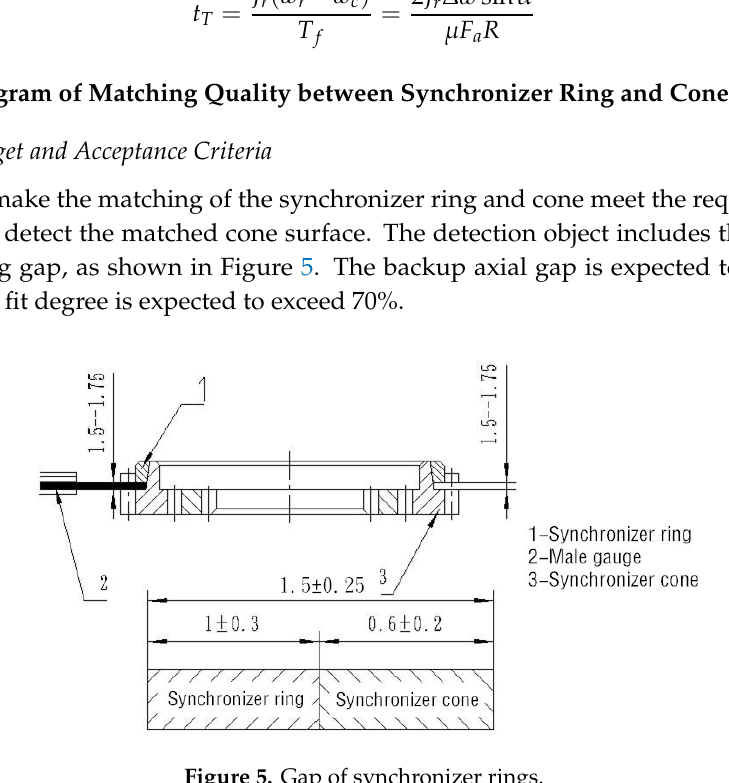
Figure 5. Gap of synchronizer rings.